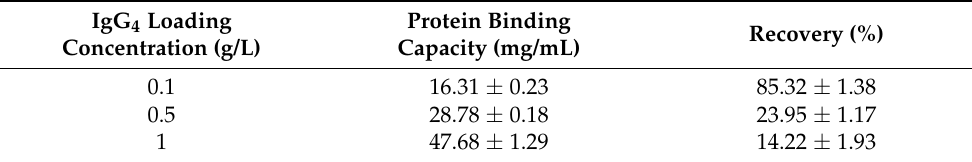
Table 6. Dynamic protein binding capacity and recovery results for IgG 4